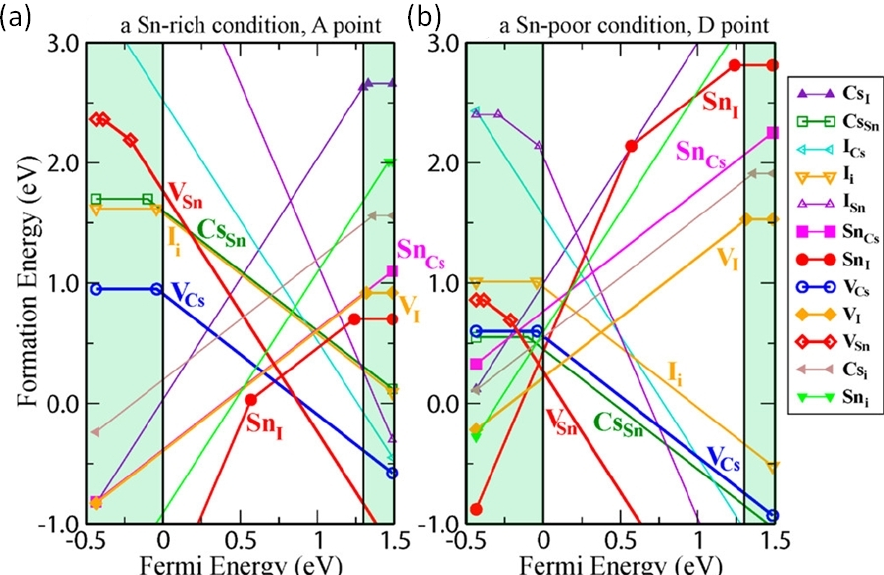
Figure 7. ( a ) Calculated formation energy of defects under Sn rich condition, ( b ) Calculated formation energy of defect states under Sn poor condition; The shaded region below the fermi energy shows the valence band and the shaded region above the fermi energy shows the conduction band. Reproduced with permission [43]. Copyright 2014, American Chemical Society.